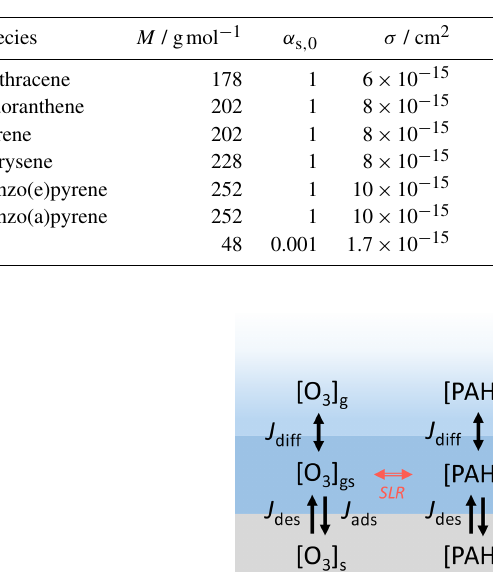
Table A2. Mass-transport parameters for adsorption of PAHs and O 3 : molar mass M ; surface accommodation coefficient on an adsorbate-free substrate α s , 0 (Julin et al., 2014); and molecular cross section σ . The gas-phase diffusion coefficient D g used for PAHs is 0.06cm 2 s − 1 (Siddiqi et al., 2009), and that for O 3 is 0.14cm 2 s − 1 (Massman, 1998).